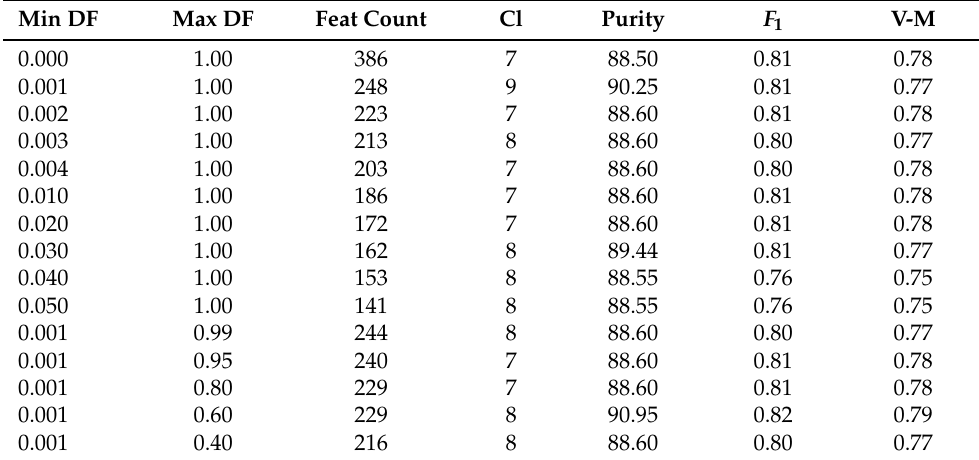
Table 5. Data Set 1C TF/IDF performance.